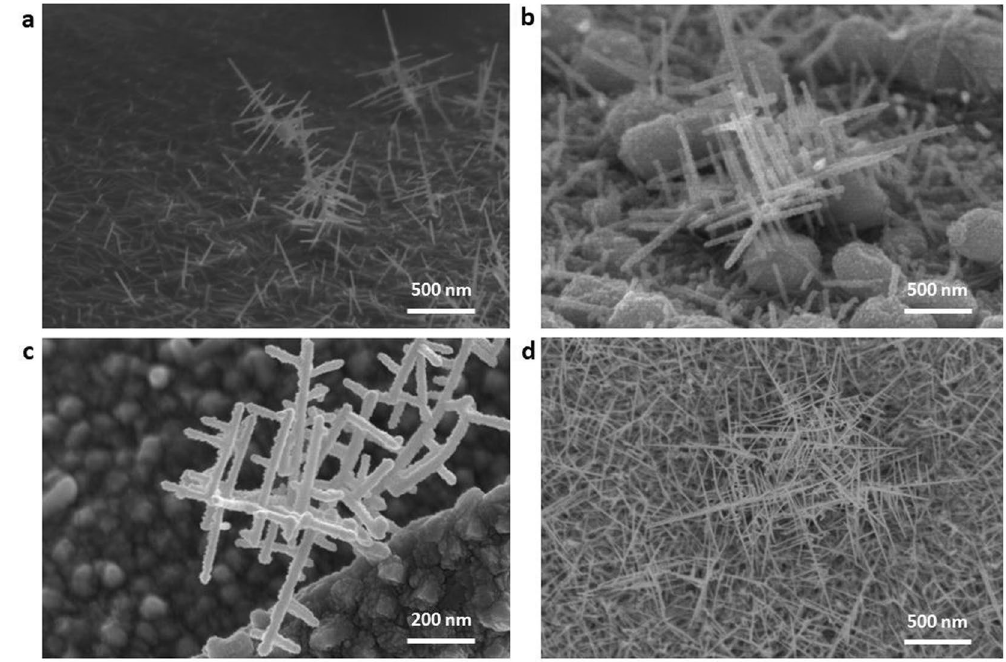
Figure 2. The growth morphologies of 3D ITO nanowires. ( a ) The ITO nano-trees grow on Si substrate. ( b ) The oriented growth of nanowires. ( c ) The ITO nanowires grow on Ni substrate. ( d ) The 3D ITO nanowire